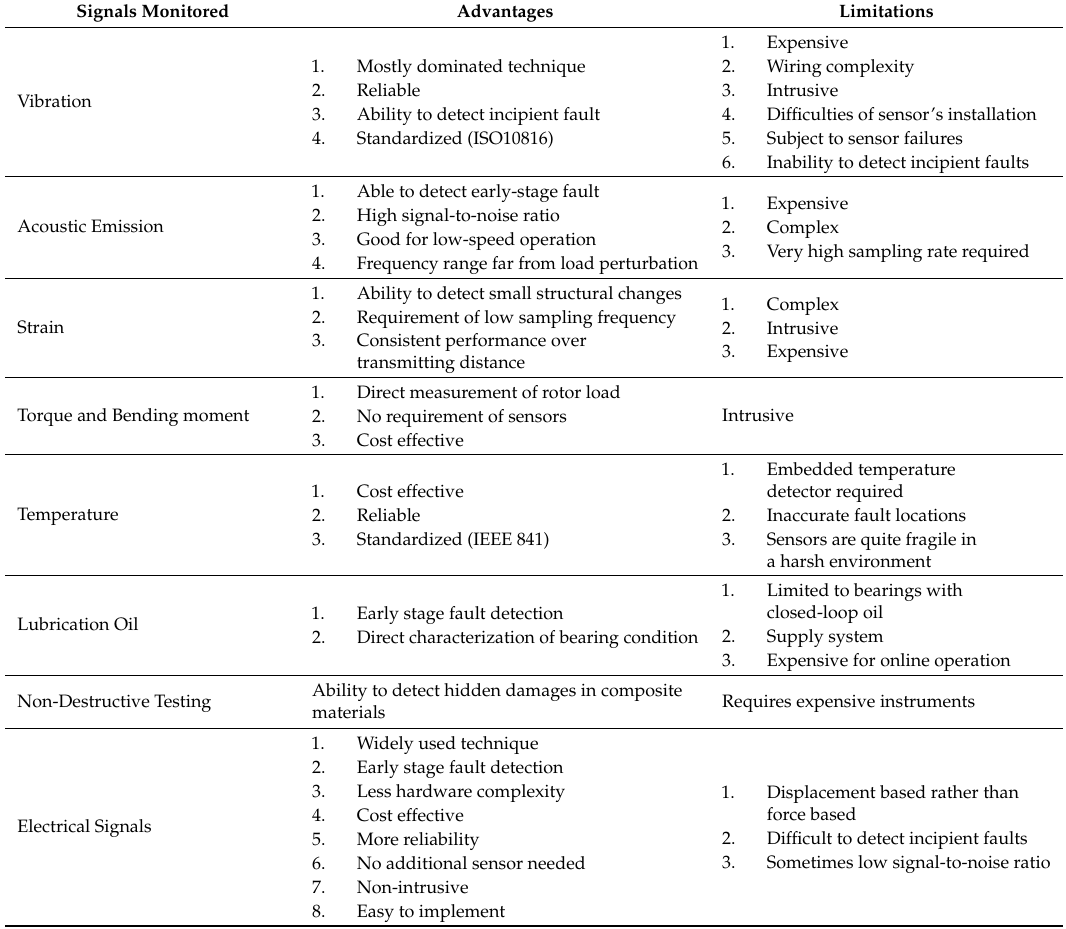
Table 2. Summary of different signals of condition monitoring for wind turbine (WT).